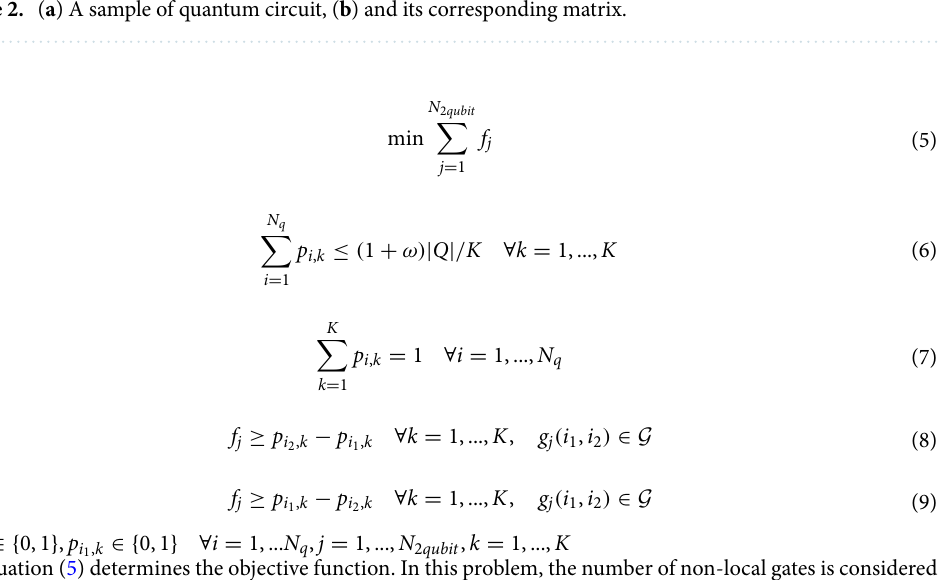
Figure 2. ( a ) A sample of quantum circuit, ( b ) and its corresponding